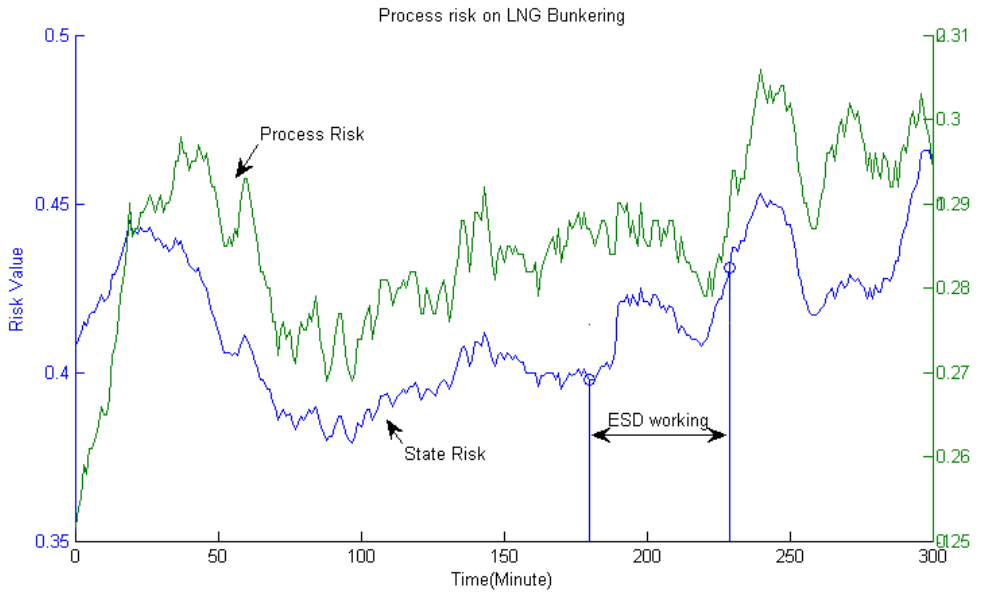
Figure 8. Risk evolution on the bunker operation of the LNG-fueled vessel.